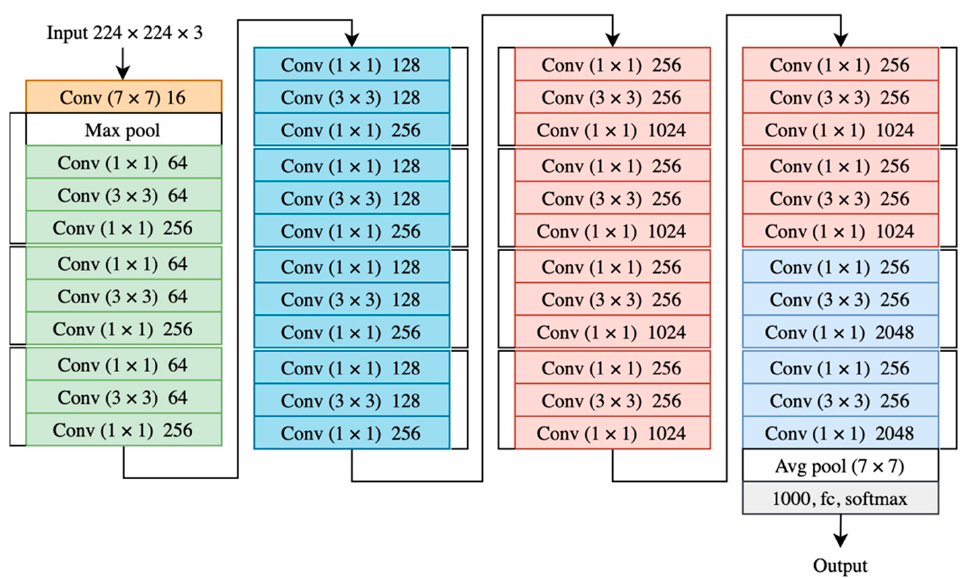
Figure 2. ResNet50 architecture where each color represents a block of layers with the same kernel